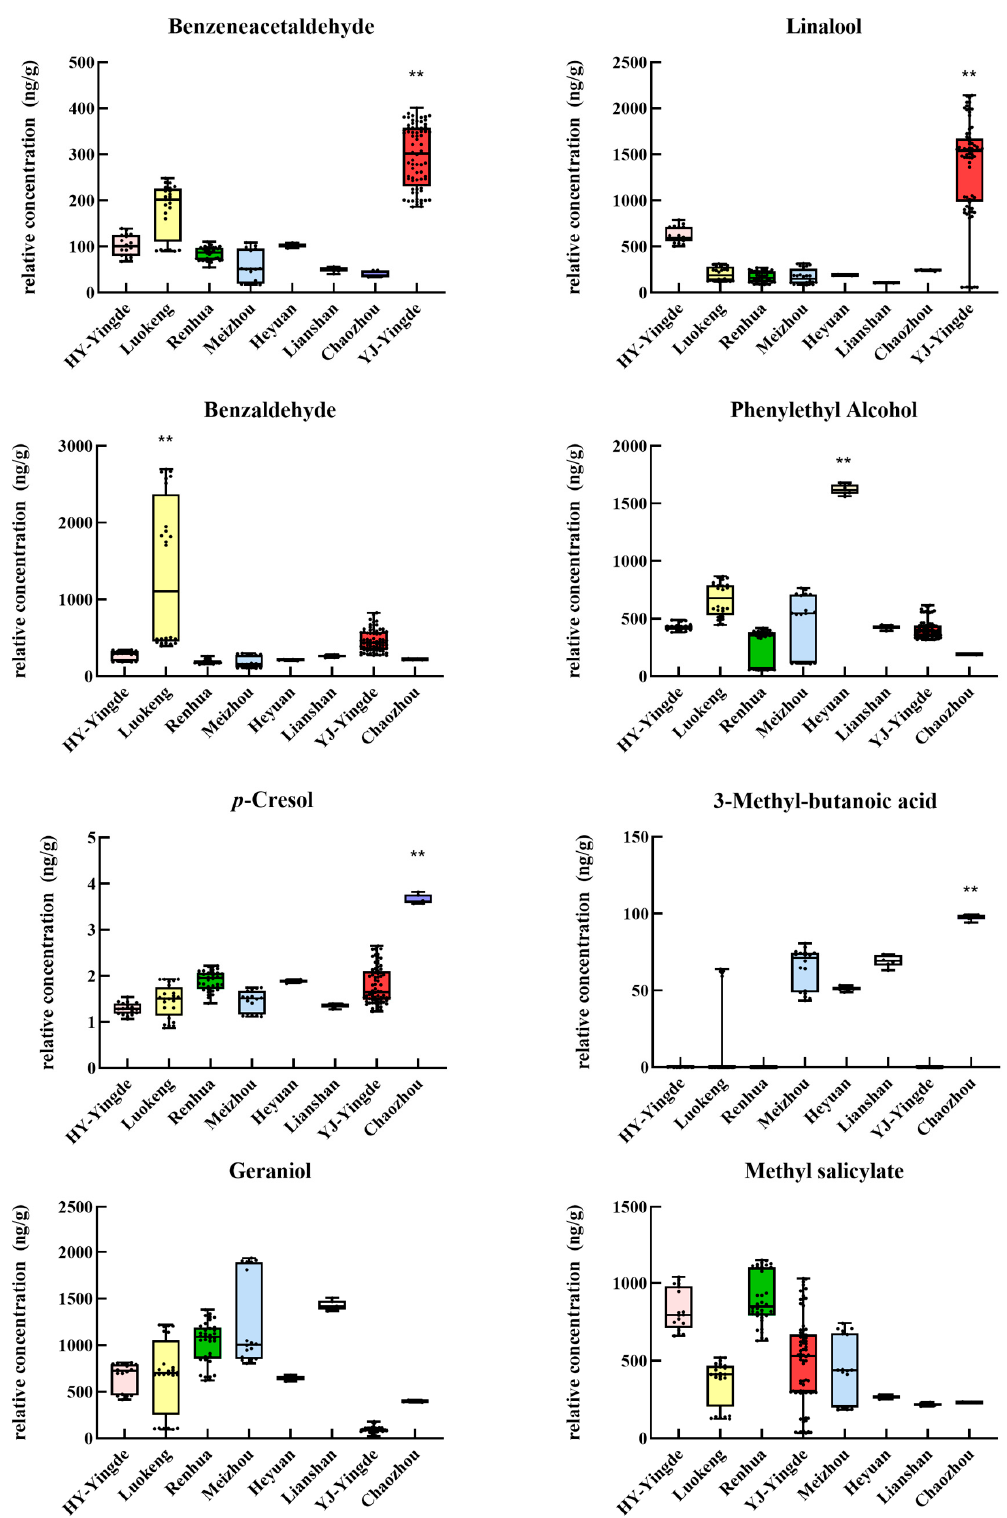
Figure 5. Relative concentration of nine differential VFCs with an OAV greater than 1 in black teas from the seven districts in Guangdong Province. ** indicates that the relative content of the compound in this district is significantly different (higher) than that in other districts ( p < 0.01). The relative concentration of the nine differential VFCs presented here is calculated according to the concentration of ethyl